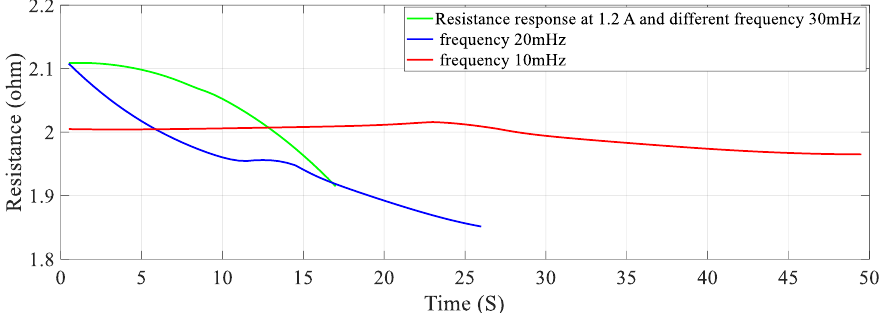
Figure 10. Effect of frequency on Resistance of the Shape memory Spring.